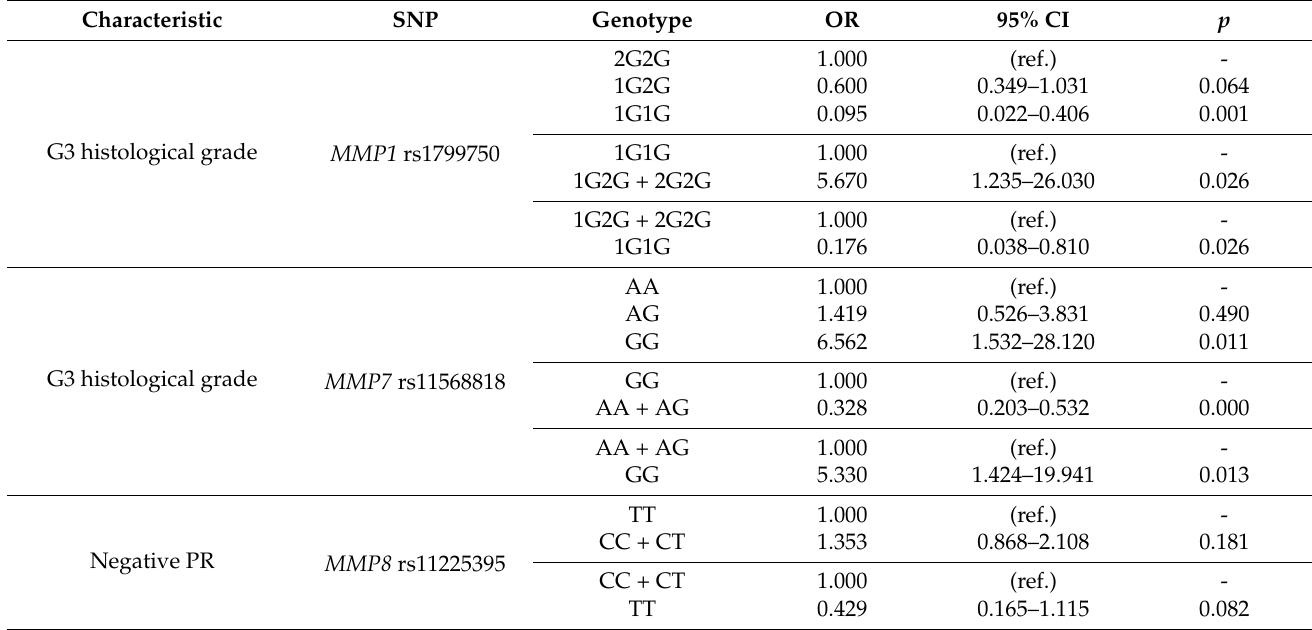
Table 4. Univariate logistic regression analysis. The odds ratio for association between SNP and tumor